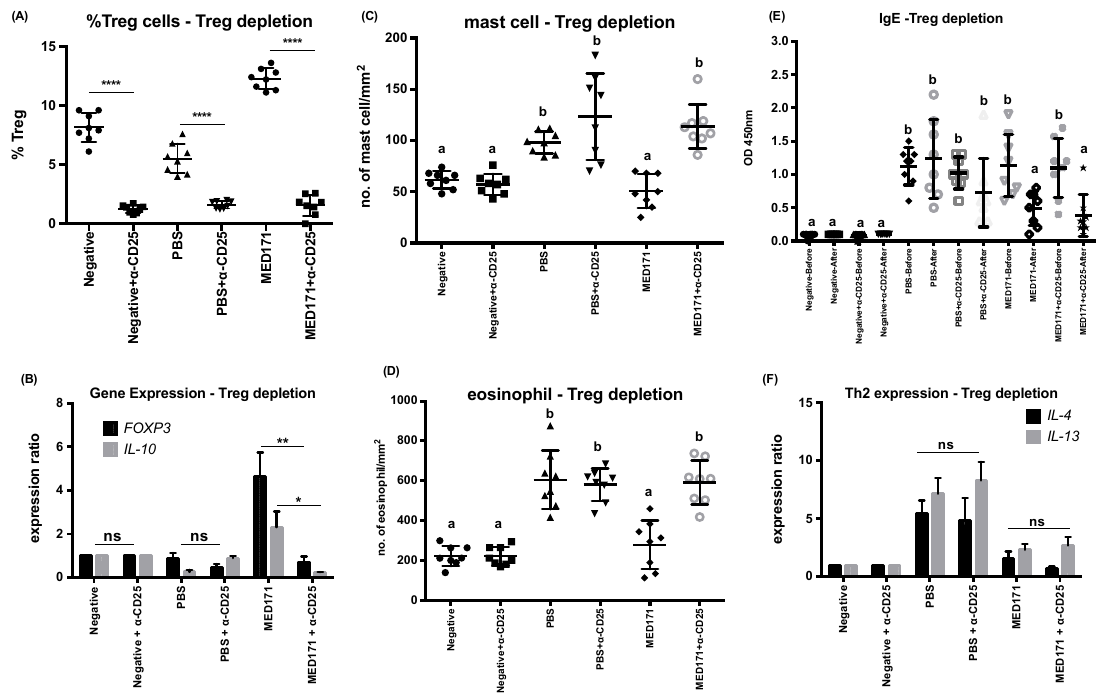
Figure 3. Immunological responses with Treg cell depletion. Intraperitoneal injection of anti-CD25 antibody 24 h prior to allergen challenge led to ( A ) significant reduction of splenic Treg cell frequencies below 2% and ( B ) significant downregulation of both FOXP3 and IL-10 in the gut. Statistical differences between Treg-depleted and non-depleted groups were assessed by Mann–Whitney U test. * p < 0.05, ** p < 0.01, and **** p < 0.0001. Quantification of ( C ) mast cells per mm 2 of crypt area and ( D ) eosinophils per mm 2 of villus in the small intestine. Levels of serological ( E ) tropomyosin-specific IgE measured by ELISA and ( F ) local expression of Th2 cytokines in the small intestine detected by qPCR. Note that Treg cell depletion in pMED171-treated animals only led to restoration of local inflammatory responses but not systemic Th2 activities. Data are shown as individual data points denoted by different symbols for each experimental group with mean ± SD. Statistical differences among different experimental groups were determined by Bonferroni post-test after one-way ANOVA. Groups denoted by the same alphabet are not significantly different, while those denoted by different alphabets are statistically different ( p < 0.05). ns = not significant.